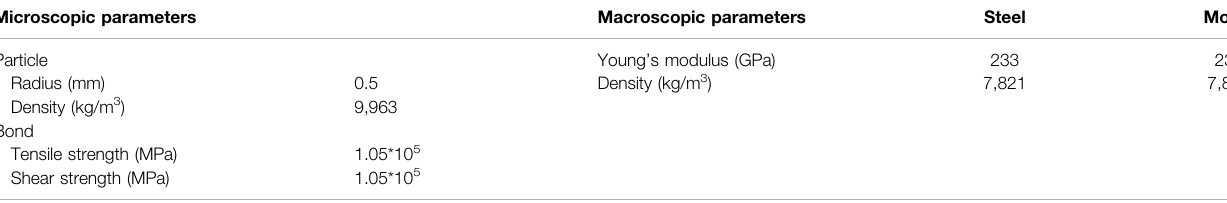
TABLE 1 | The microscopic and macroscopic parameters of the bars. Microscopic parameters